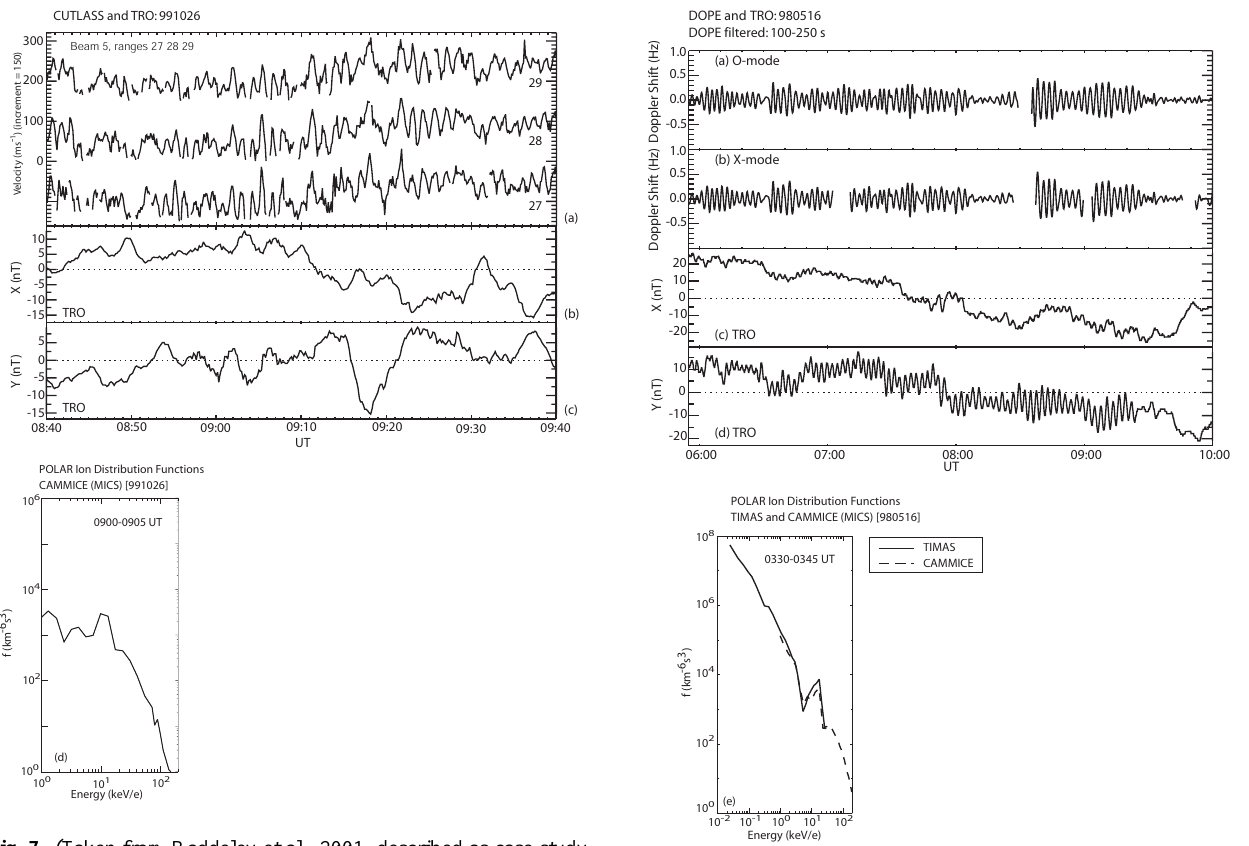
Figure 7. Fig. 7. (Taken from Baddeley et al., 2001, described as case study 1 in this paper) Data from 26 October 1999, ( a ) CUTLASS stack plot for beam 5, range gates 27–29. ( b ) and ( c ) Corresponding measurements of the ground magnetic field at Tromsø, for both the X and Y components. ( d ) The conjugate driving ion distribution functions, IDFs, derived from the CAMMICE (MICS) instrument for the interval on 26 October 1999, 09:00:00–09:05:00 UT.